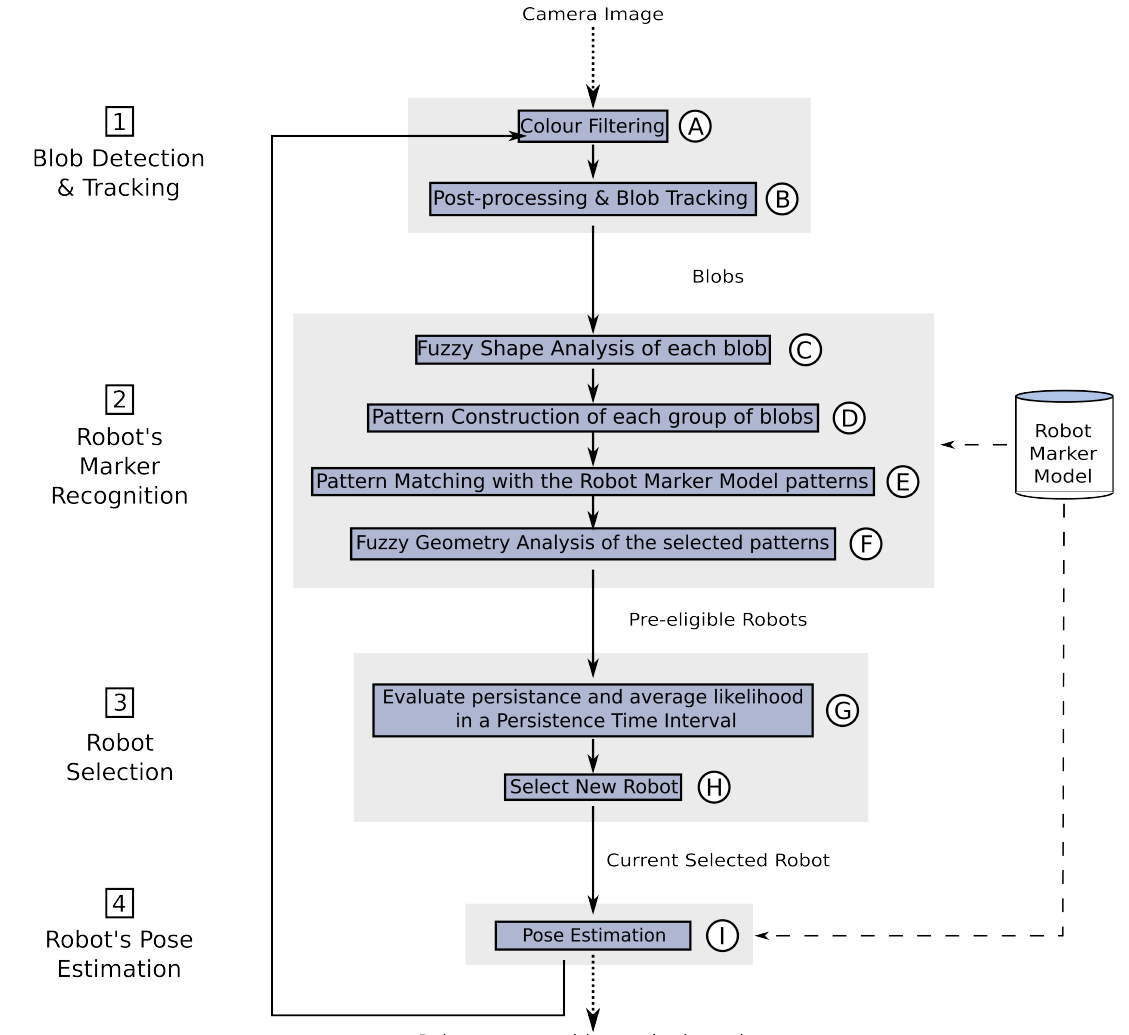
Figure 7. Robot detection and tracking algorithm. Continuous arrows indicate flow of execution. Dashed arrows indicate influence relationships. Dotted arrows indicate data